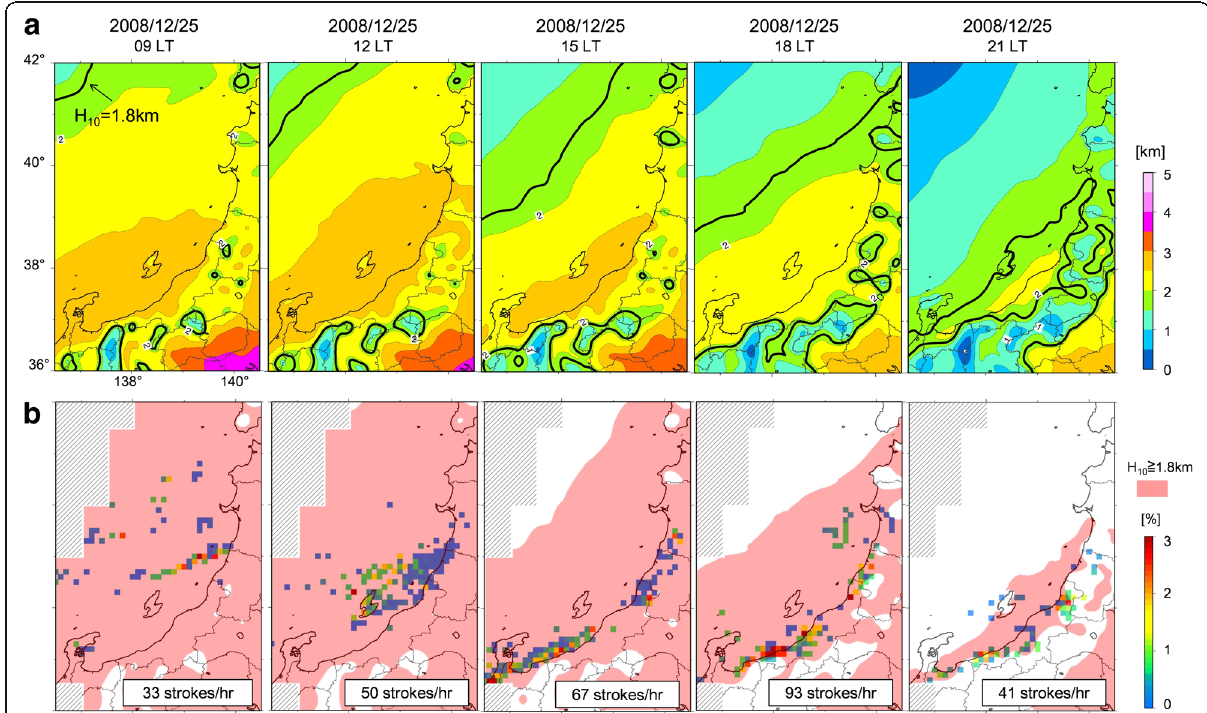
Fig. 15 Comparisons of H 10 with lightning frequency distribution for case B. a H 10 distribution. b Composite maps of lightning frequency distribution and regions where H 10 exceeds 1.8 km ( highlighted in pink